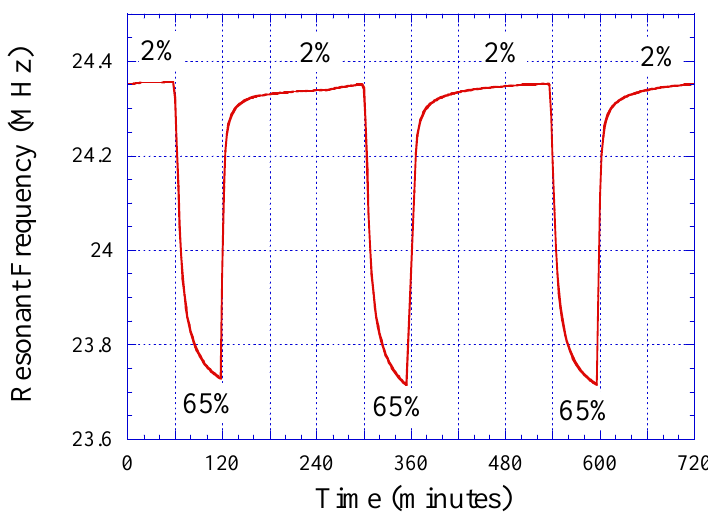
Figure 11. The response of the sensor when it was cycled between 2% RH and 65% RH at room temperature (24 (cid:176)